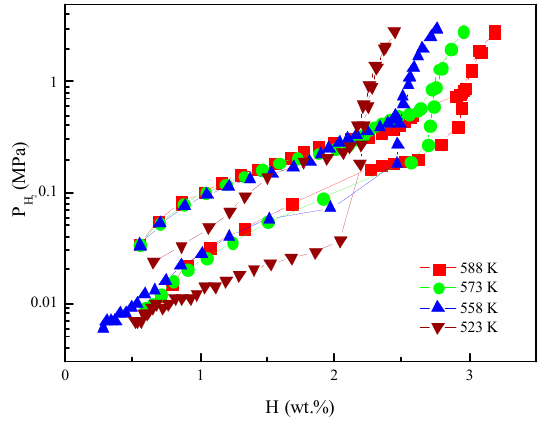
Figure 4. The P–C–T curves of the La 7.0 Mg 75.5 Ni 17.5 alloy at different temperatures.